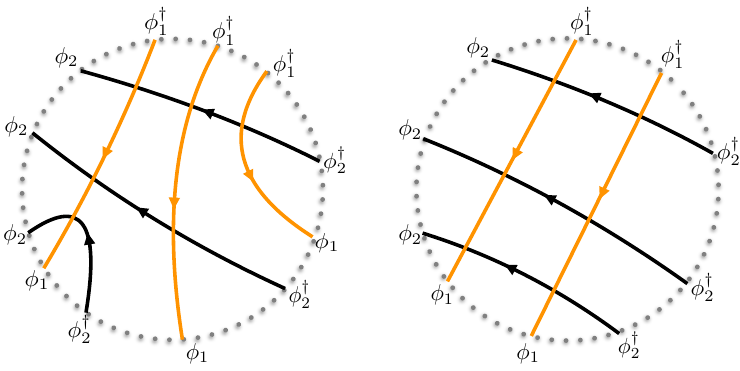
Figure 1 . Bi-scalar amplitude diagrams. (A): M